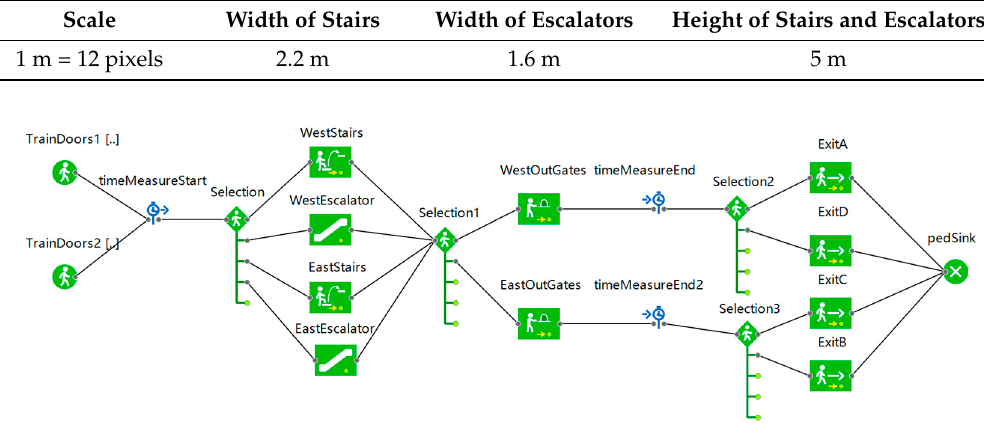
Figure 6. The outbound pedestrian behavior model.